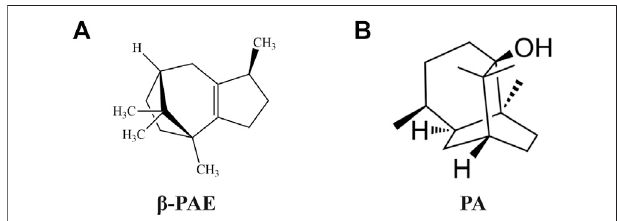
FIGURE 1 | Chemical structure formula. (A) β -PAE; (B)